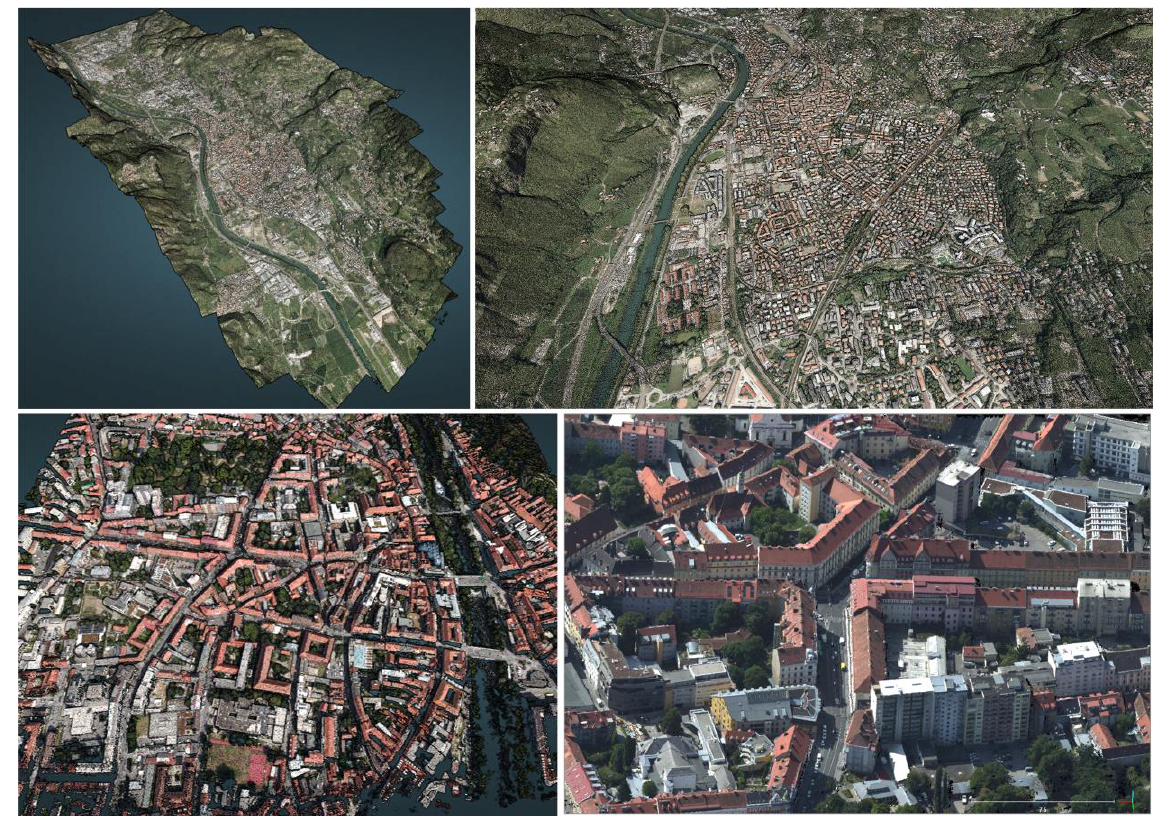
Figure 5. DSM cloud (5.5 billion points) of Trento (top) and 3D point cloud of Graz